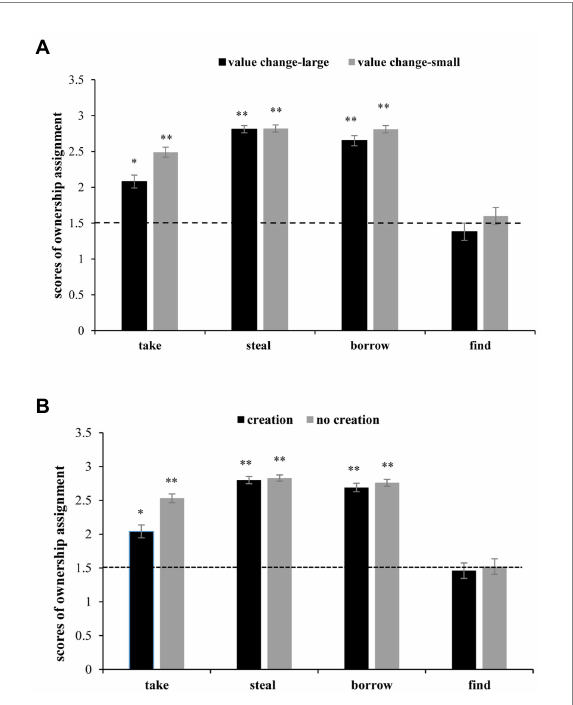
FIGURE 1 Ownership scores in different transfer conditions in Study